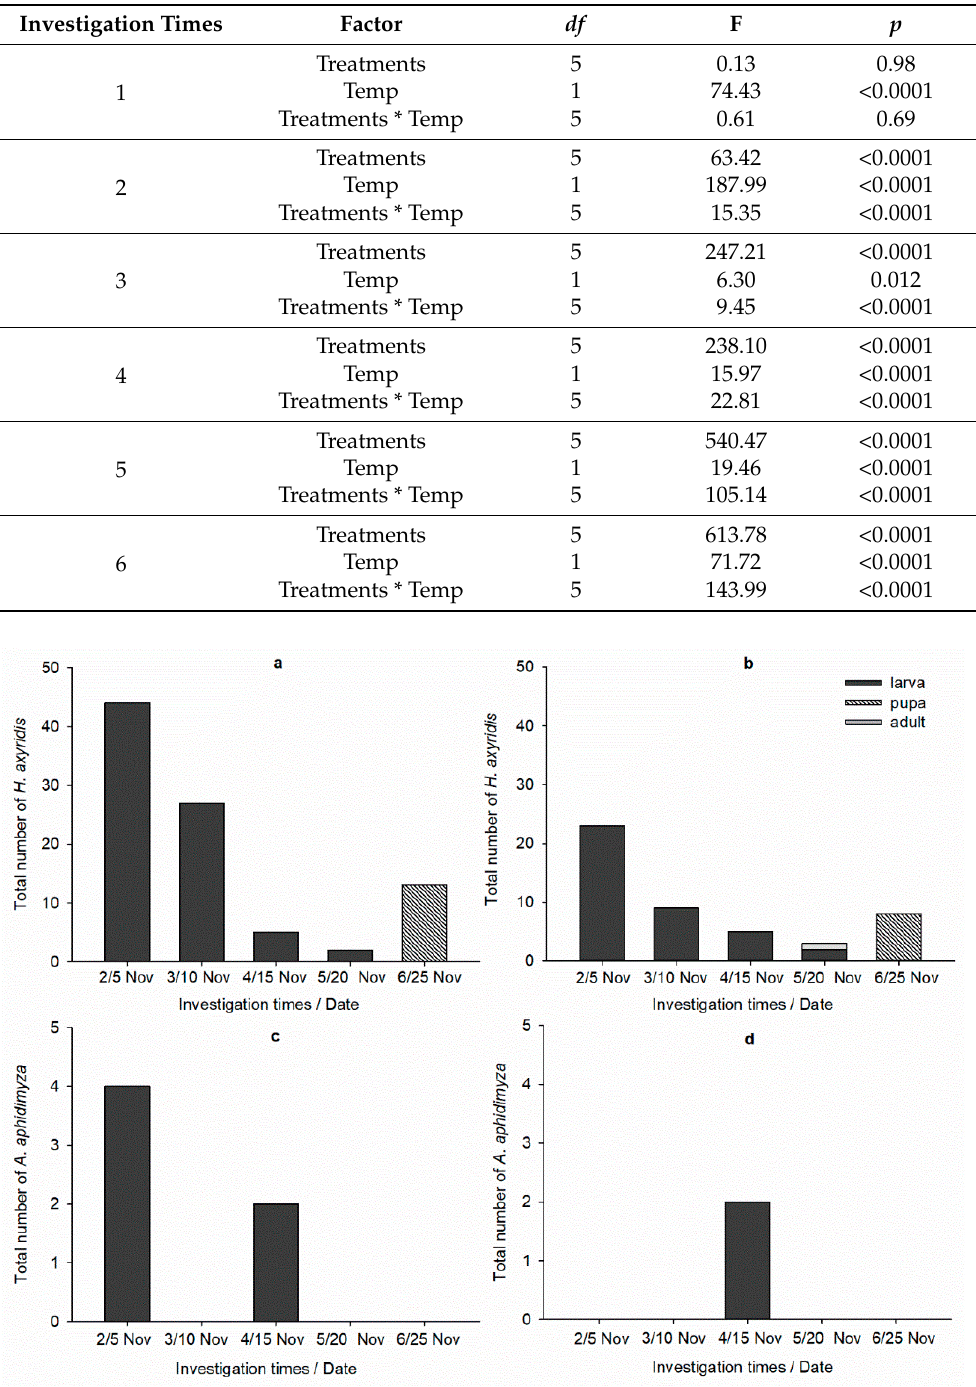
Figure 2. Number of predators in each treatment under low temperature. ( a ) H. axyridis , ( b ) low-dose thiacloprid and H. axyridis , ( c ) A. aphidimyza , ( d ) low-dose thiacloprid and A. aphidimyza